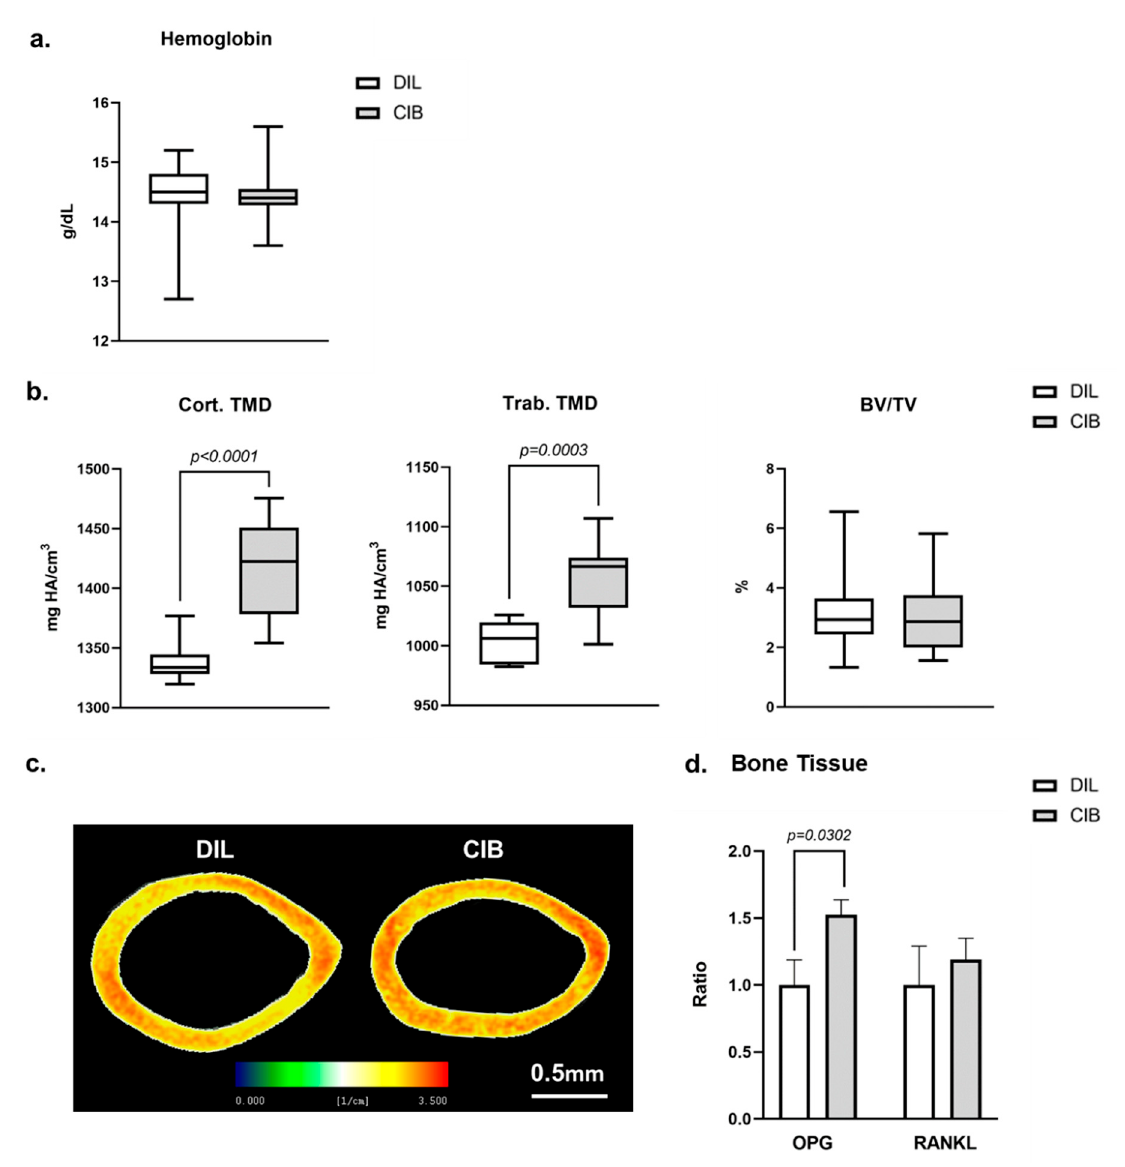
Figure 5. Cibinetide (CIB) increases tissue mineral density (TMD) in both cortical and trabecular bone. ( a ) Hemoglobin levels in Cibinetide versus diluent injected mice. ( b ) μ CT analysis in the mid- diaphyseal cortical and distal trabecular femoral bone of diluent and Cibinetide injected 12-week-old female mice with respective representative images ( c ). Box plots represent median, quartiles and extremes. In ( c ), the color spectrum reflects the mineral density gradient across the section of the cortical bone. The upper limit of the scale (3.5/cm) corresponds to 1764 mg HA/cm 3 . ( d ) OPG and RANKL mRNA expression levels in whole bone from diluent vs. Cibinetide treated mice. In ( d ) ΔΔ CT values are normalized to the diluent group; values are mean ± SEM. N = 9–10 mice in each group.